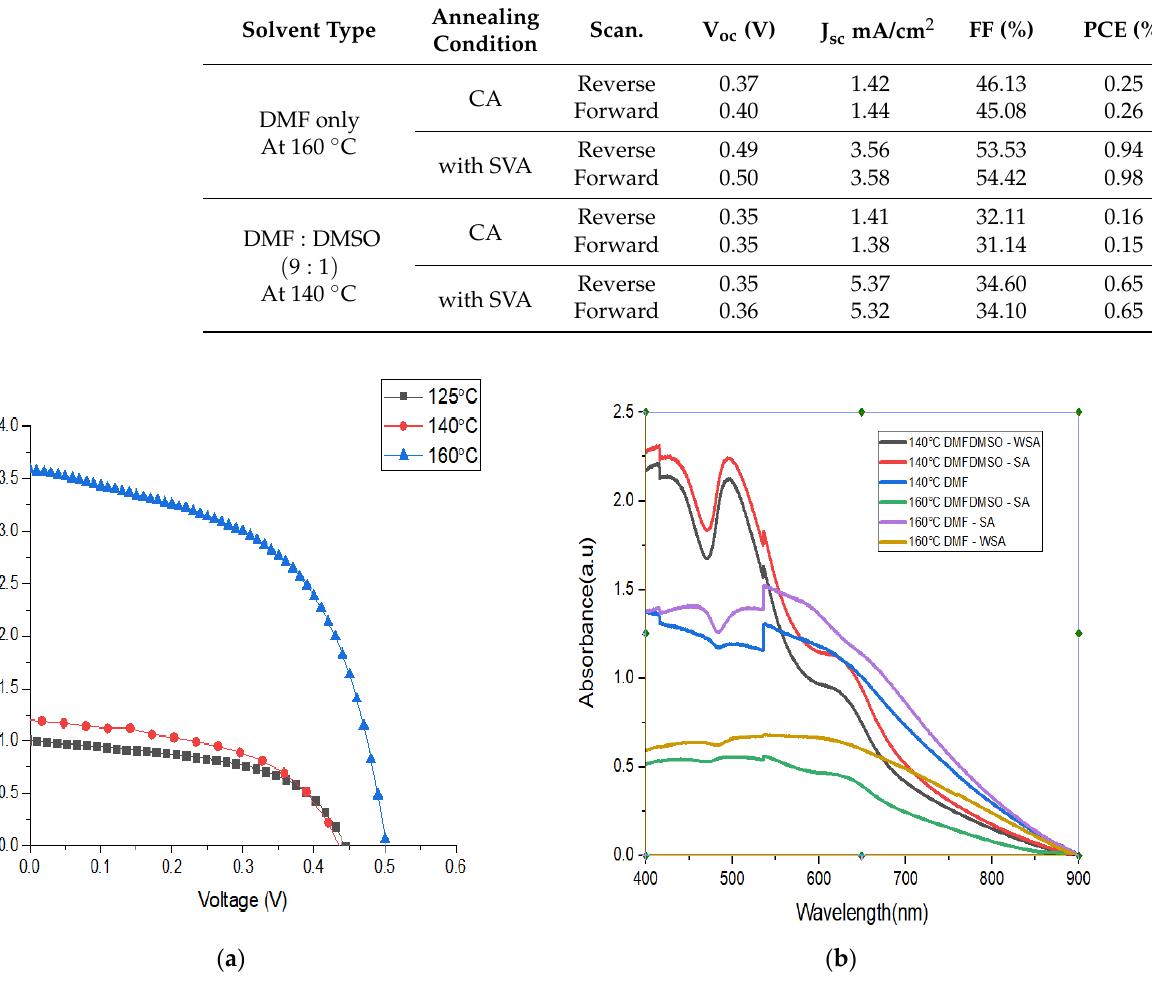
Figure 5. ( a ) The effect of annealing temperature on I–V characteristics; ( b ) effect of solvent type on absorption